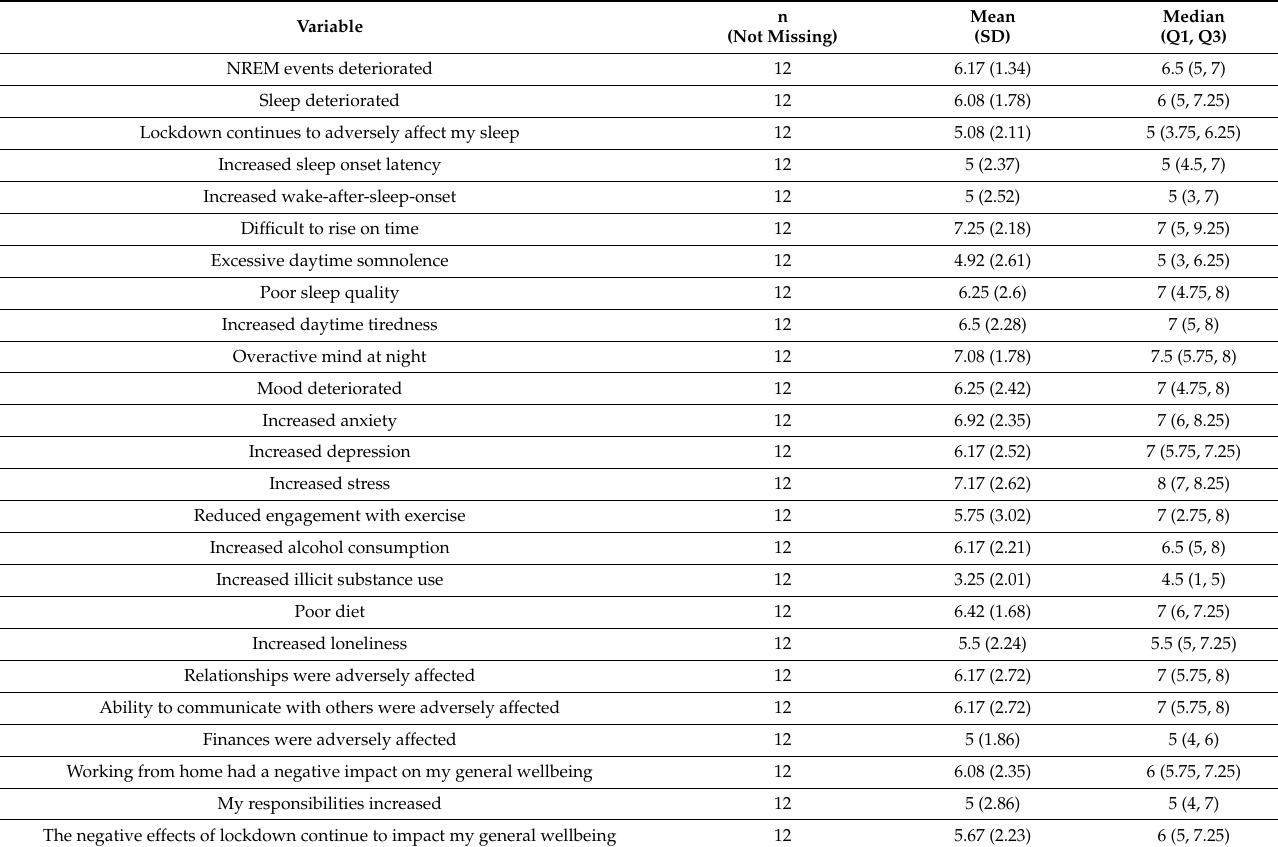
Abbreviations: ICLQ = Impact of COVID-19 Lockdown